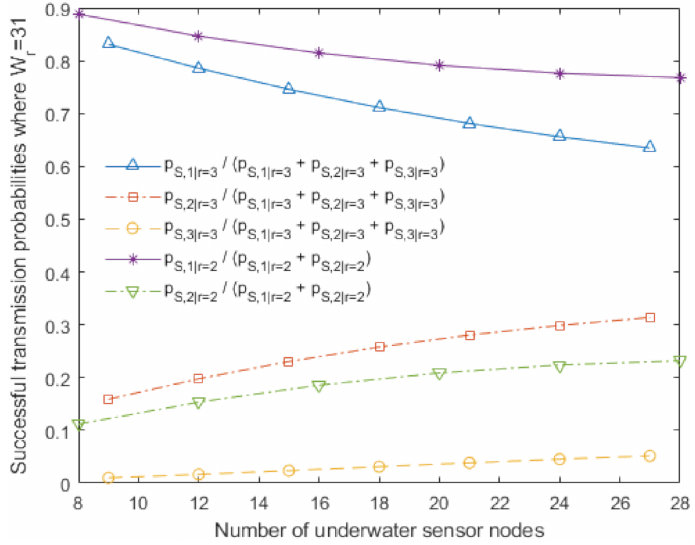
Figure 8. Successful transmission probabilities for the proposed underwater multi-DATA train protocol with r = 2 and r = 3 when W r =